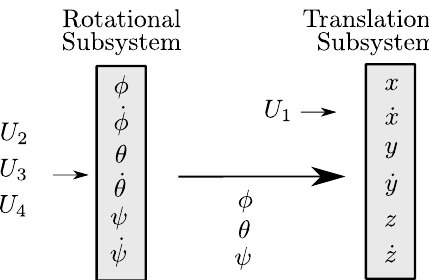
Figure 4. U 2 , U 3 and U 4 are inputs for the rotational subsystem; U 1 , roll, pitch and yaw are inputs for the following translation